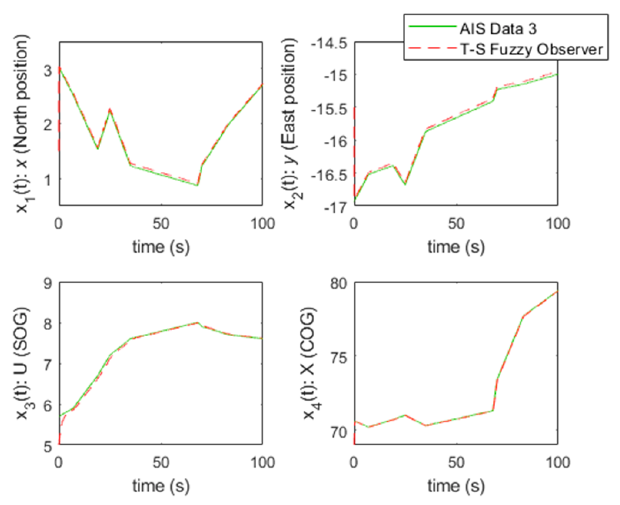
Figure 12. Simulation results of AIS data 3.